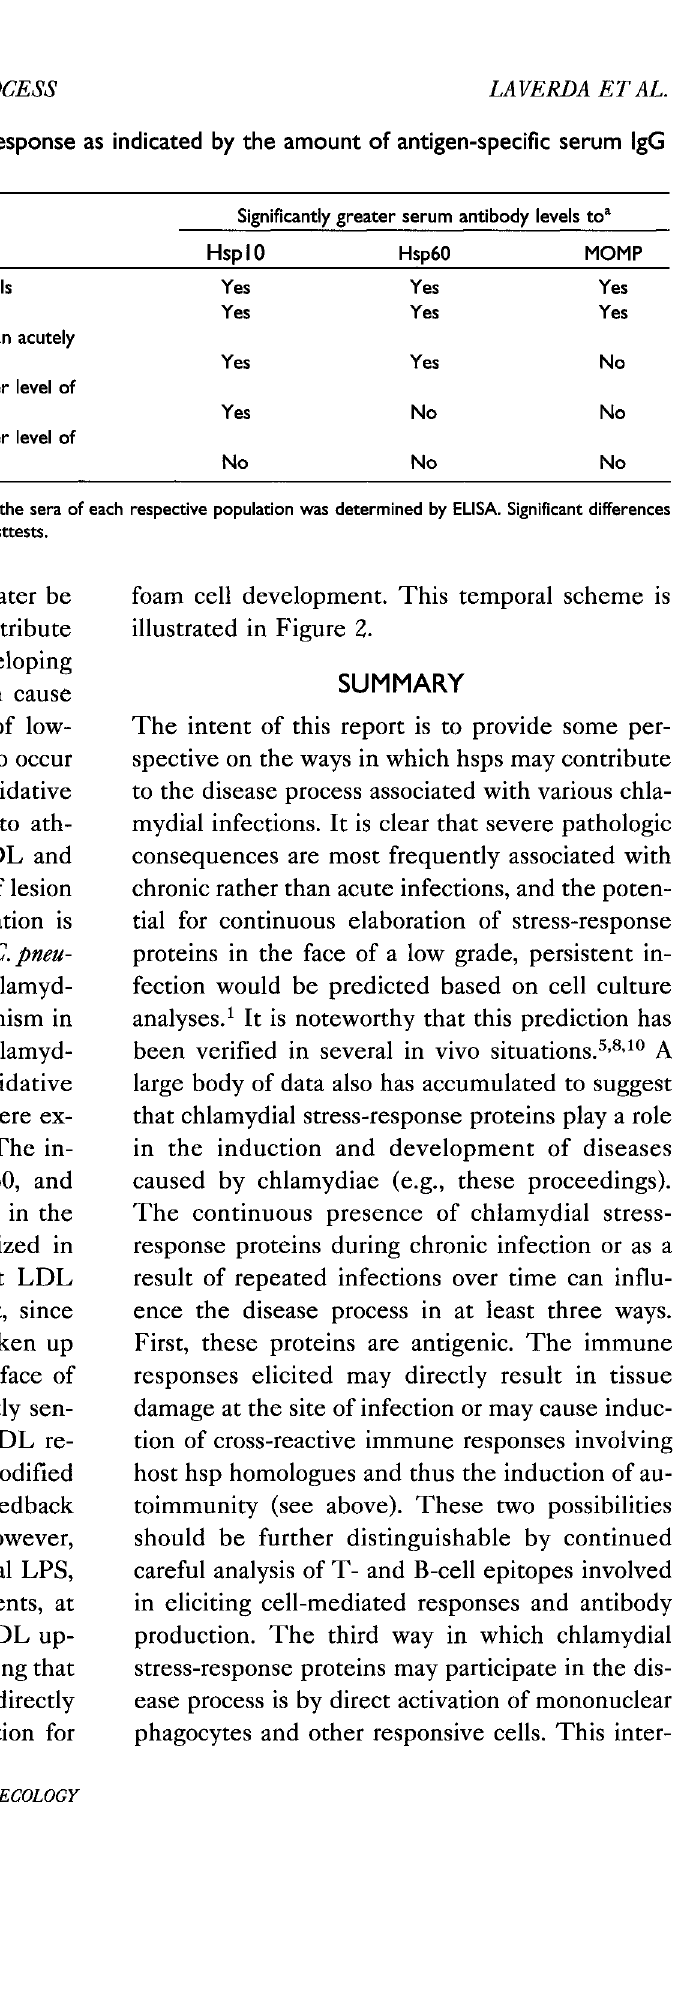
TABLE 2. Comparison of the magnitude of response as indicated by the amount of antigen-specific serum IgG present by group and subgroup Group Hspl0 Hsp60 MOMP Acutely infected women, compared to uninfected controls Women with TFI, compared to uninfected controls Do women with TFI have a greater level of response than acutely infected women? For EB+ patients only, do women with TFI have a greater level of response than acutely infected women? For EB- patients only, do women with TFI have a greater level of response than acutely infected women?